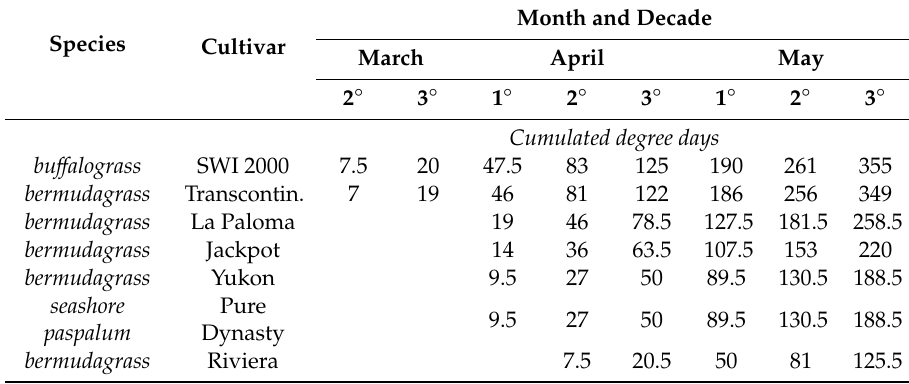
Table 4. Cumulated degree days per 10-days for seven cultivars of warm-season turfgrass species in March, April and May. These values were calculated by using weather data and the estimated parameters in Table 3. The time intervals with degree days highlighted in bold are those necessary to reach the thermal time for the 30th percentile ( θ T(30) ). The cultivars are listed by increasing Tb value. Species